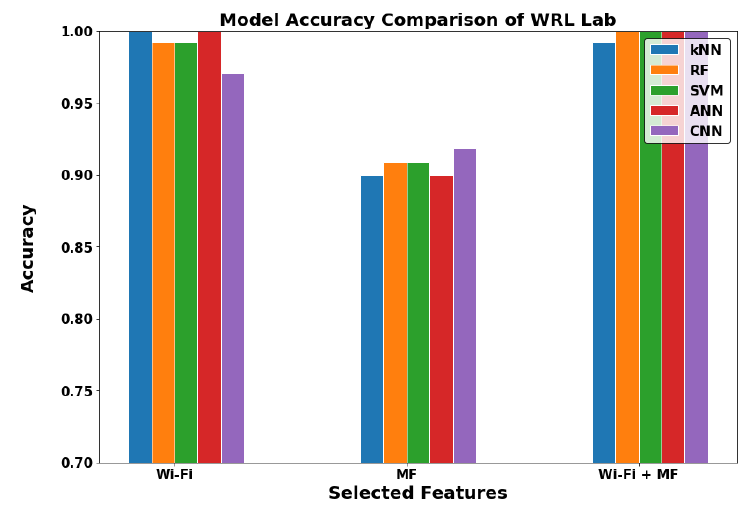
Figure 12. The models comparison in WRL Lab (Indoor).